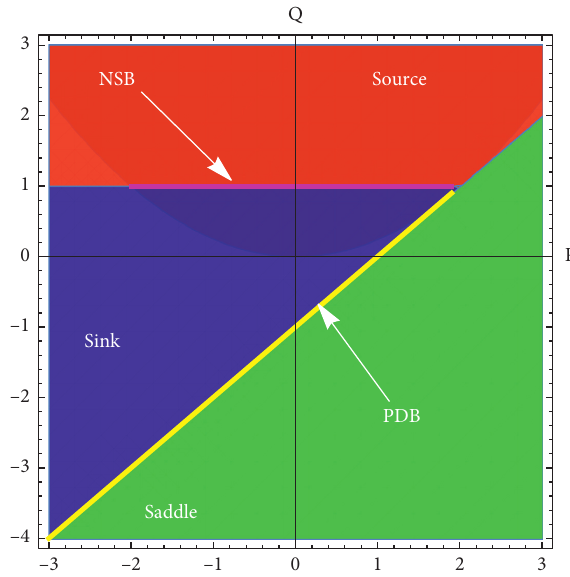
Figure 2: Dynamical classification of planar system with S ( 1 ) > 0.